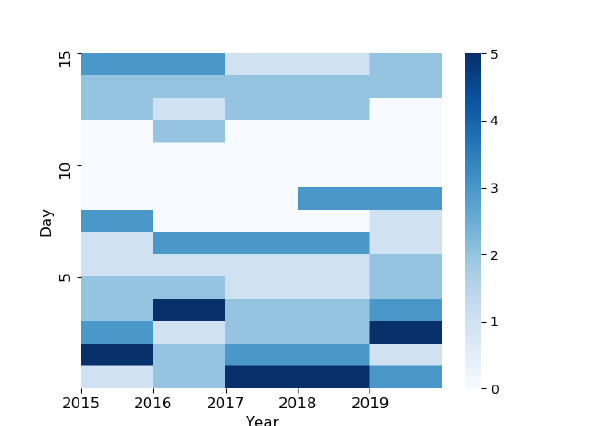
Figure 10: Clustering output for NO 2 for first 15 days in Q 4 over 2015 to 2019.